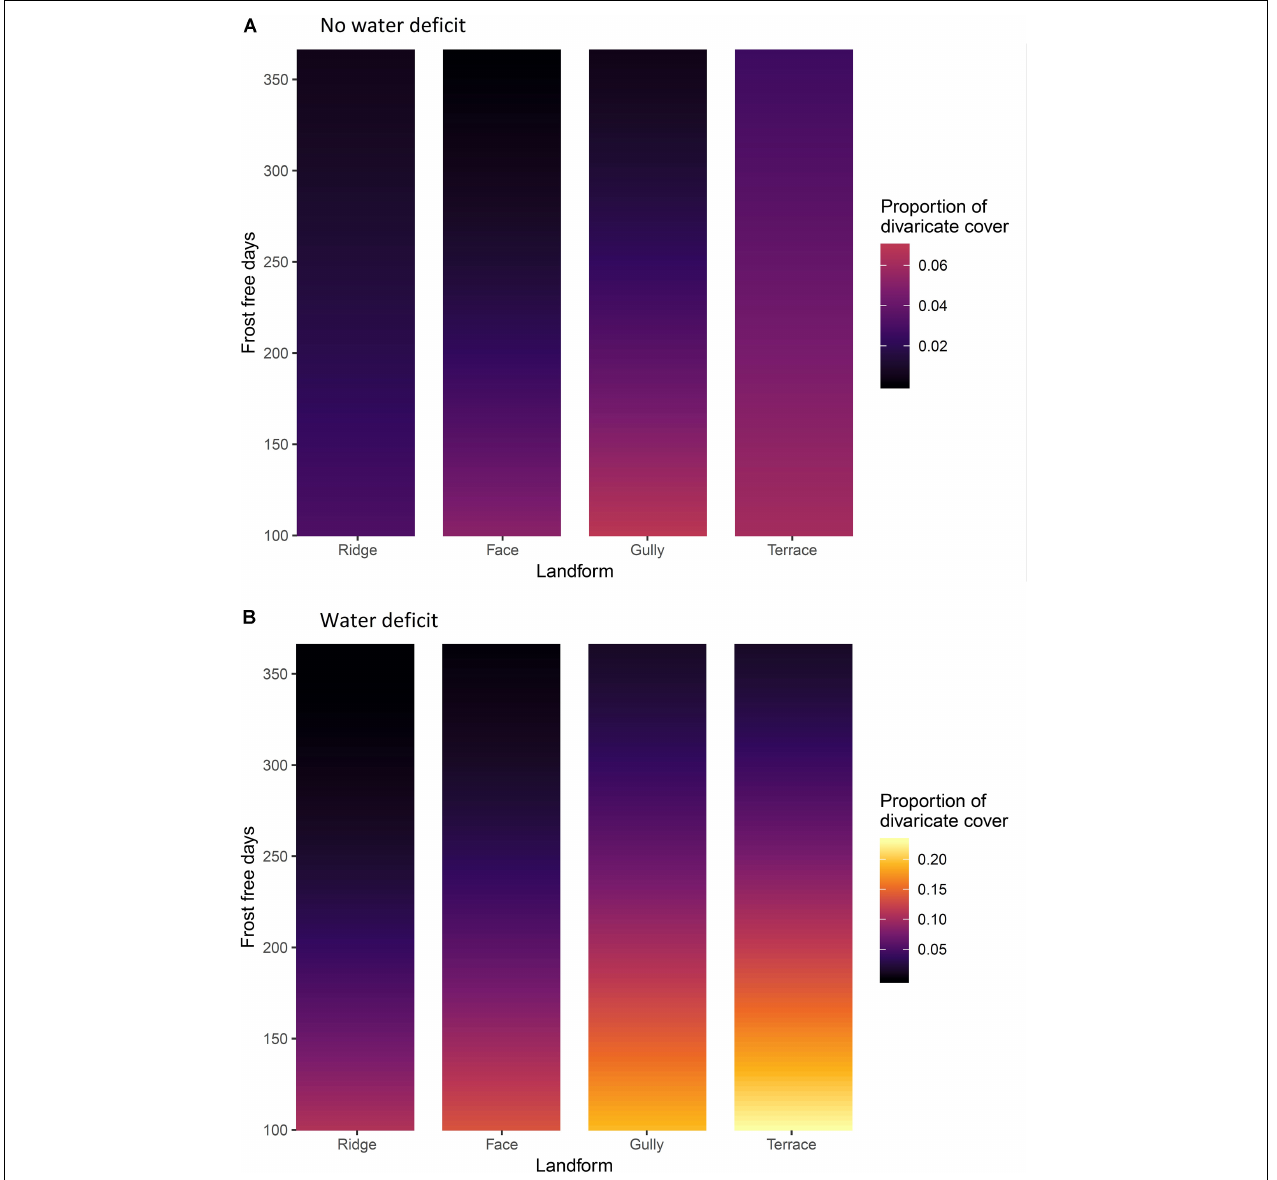
FIGURE 6 | (A) Sites without water deficit, i.e. precipitation exceeds evapotranspiration in all months of the year. (B) sites with an annual water deficit, i.e. where evapotranspiration exceeds precipitation during some months. The effects of frost-free period and topographic position on divaricate species’ cover on 9,601 relevé forest plots in New Zealand. Yellow = high cover of divaricate species, black = low